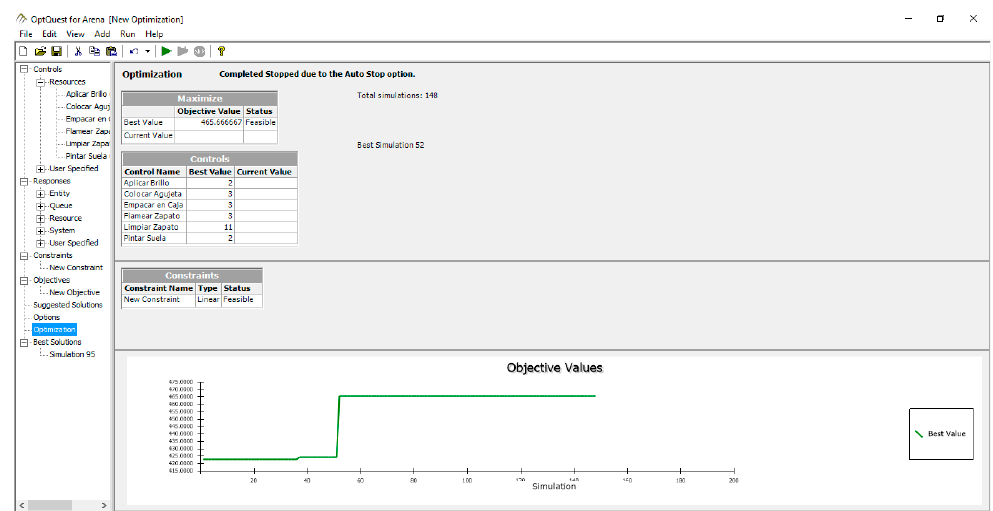
Figure A7 . Selection of resources, restrictions, and objective function.